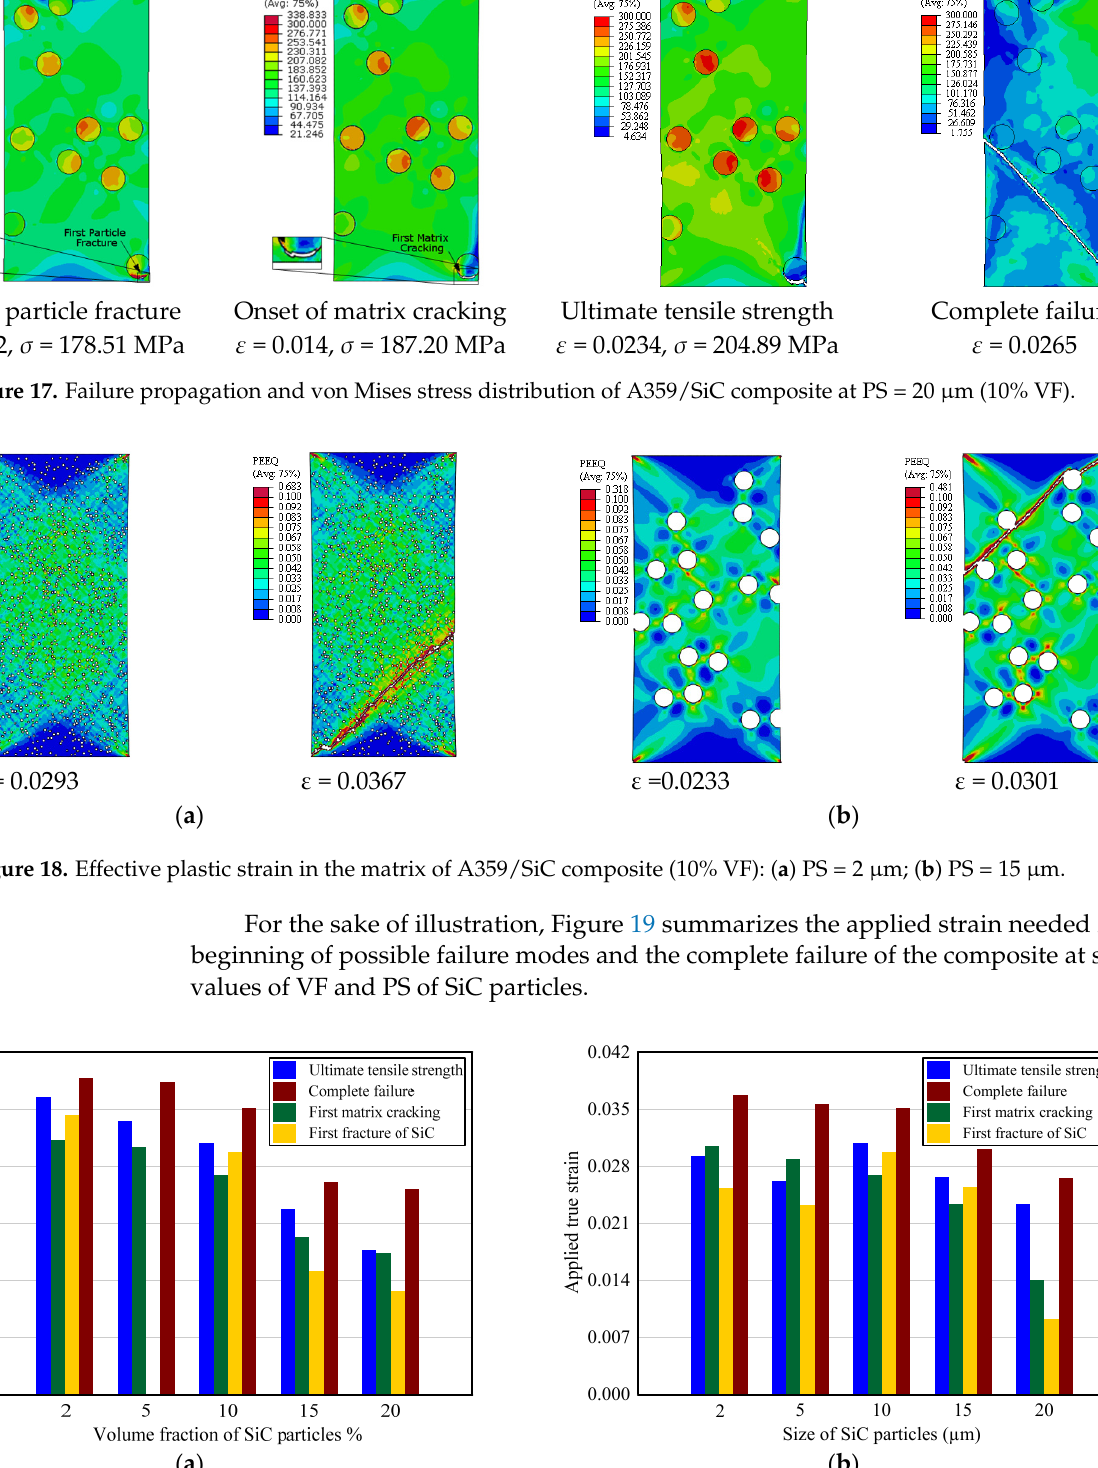
Figure 16. Failure propagation and von Mises stress distribution of A359/SiC composite at PS = 15 µm (10% VF).